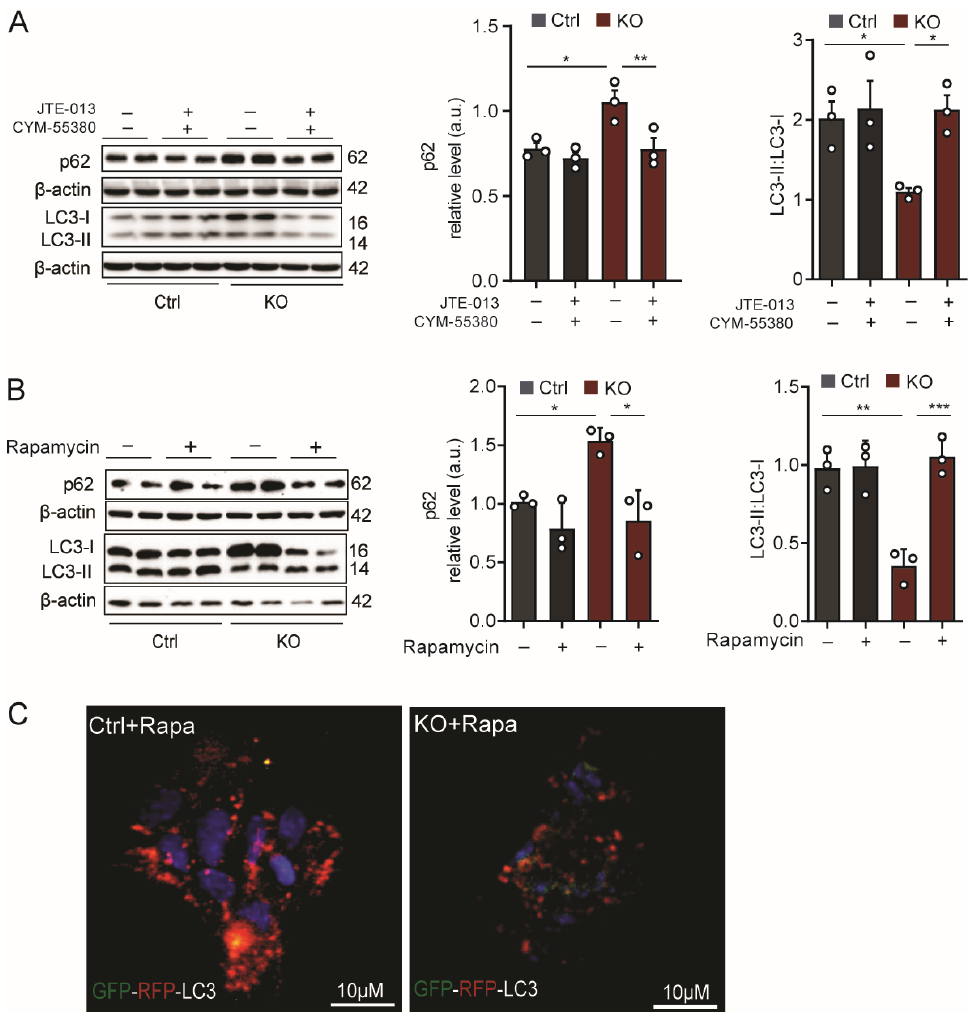
Figure 4. Rapamycin and S1PR antagonists re-establish autophagy in SGPL1-deficient astrocytes. ( A ) Quantification of autophagy marker proteins p62 and LC3-II:LC3-I in astrocytes from control (Ctrl) or SGPL1 fl/fl/Nes (KO) mice cultured for 6 h in the absence ( − ) or presence (+) of the S1PR 2 antagonist JTE-013 (10µM) and the S1PR 4 antagonist CYM-55380 (10 µM) as indicated. ( B ) Quantifica- tion of the autophagic marker proteins p62 and LC3-II:LC3-I in astrocytes from control (Ctrl) and SGPL1 fl/fl/Nes (KO) mice, cultured for 5 h in the absence or presence of rapamycin (RAPA, 5 µM) as indicated. ( C ) Representative images showing the fluorescence of the RFP–GFP–LC3 construct ex- pressed in astrocytes in the presence of rapamycin in control (Ctrl) and KO astrocytes. For all, rep- resentative immunoblots are shown with β -actin as loading control. Bars represent means ± SEM, n ≥ 3, one-way ANOVA with Bonferroni multiple comparison test, * p < 0.05, ** p < 0.001, *** p < 0.0001. Next, we inhibited S1PR 2 and S1PR 4 with JTE-013 and CYM-55380, respectively, and checked whether and how these specific antagonists affect the increased expression of the enzymes involved in glucose degradation. As shown in Figure 2D, the simultaneous ad- dition of JTE-013 and CYM − 55380 (10 µM) for 6 h reversed the expression of PFK, GAPDH, and PDH to control levels (Figure 2D). Note that, as specified above for the spe- cific agonists, inhibition with each of the two specific inhibitors alone did not reverse the